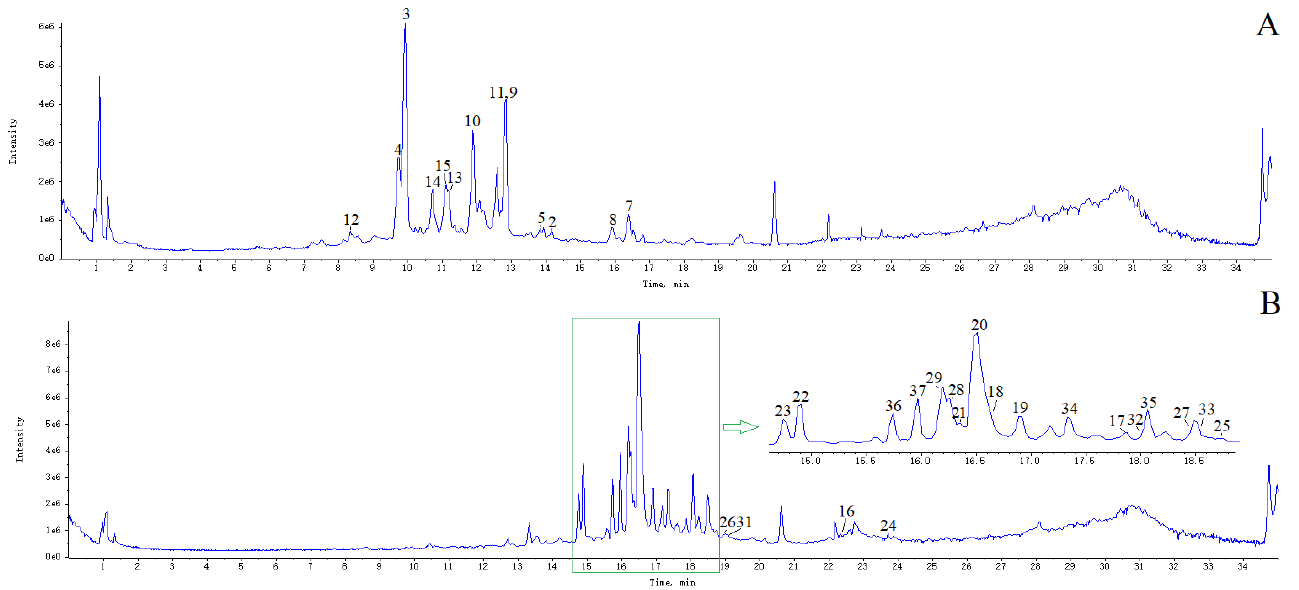
Figure 3. TIC spectra of HFPE ( A ) and HFFE ( B